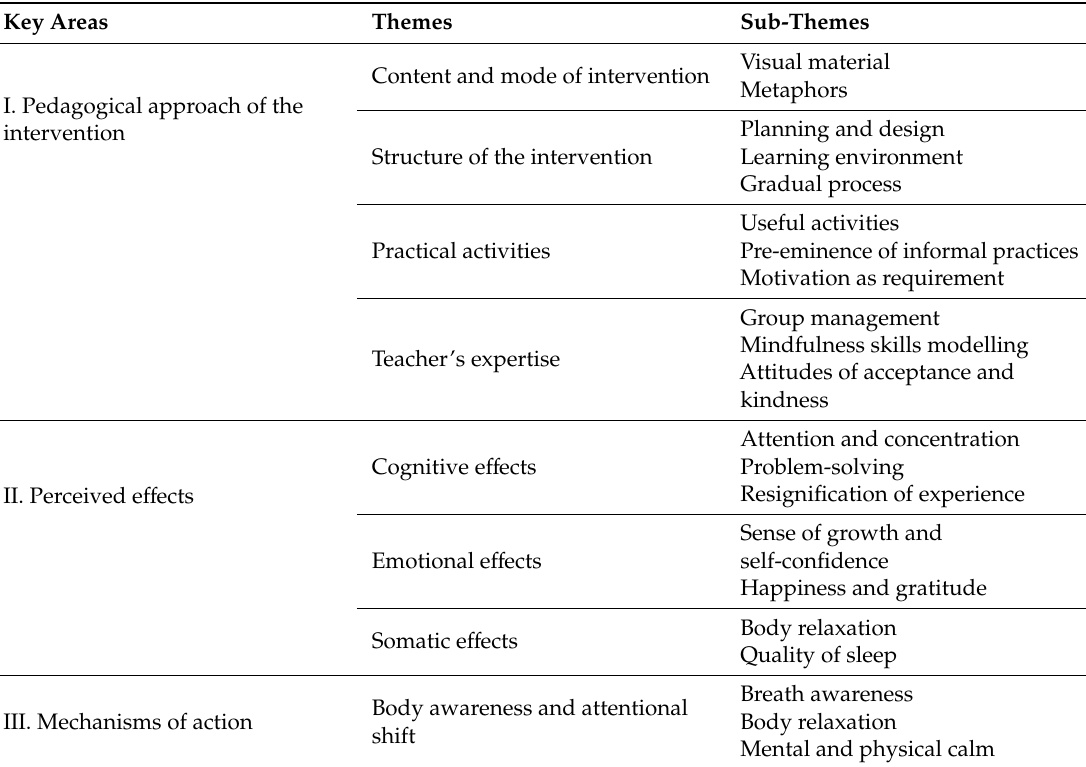
Table 2. Key areas, themes, and